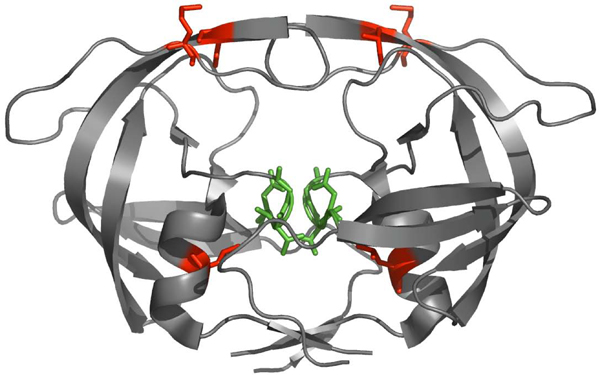
Structure of the HIV protease dimer (PDB code 1HN0). The catalytic triad (residues 25, 26, and 27) is highlighted in green, while the residues from the triple with the largest  in the PI2+ cohort (46-54-90, see Figure 9) are shown in red. Residue 90 is close to the catalytic triad, whereas residues 46 and 54 are close to each other, with the smallest distance between heavy atoms of 3.11 Å).